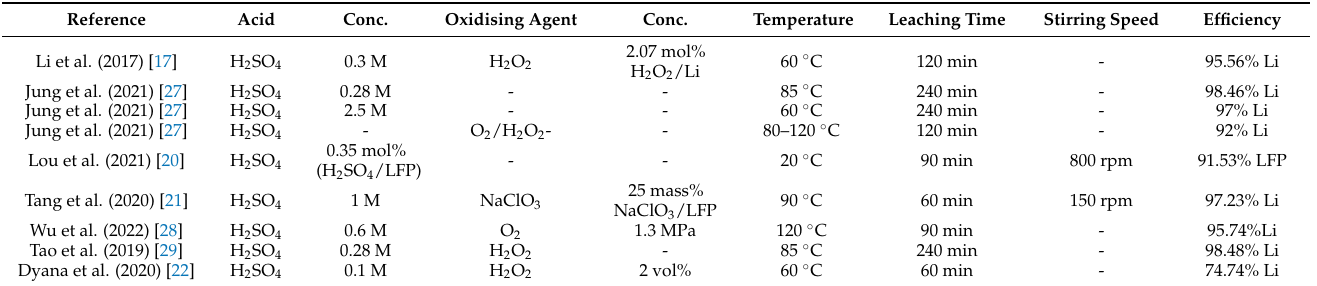
Table 2. Selected leaching parameters from relevant literature for the selective leaching of lithium and iron from LFP cathode material